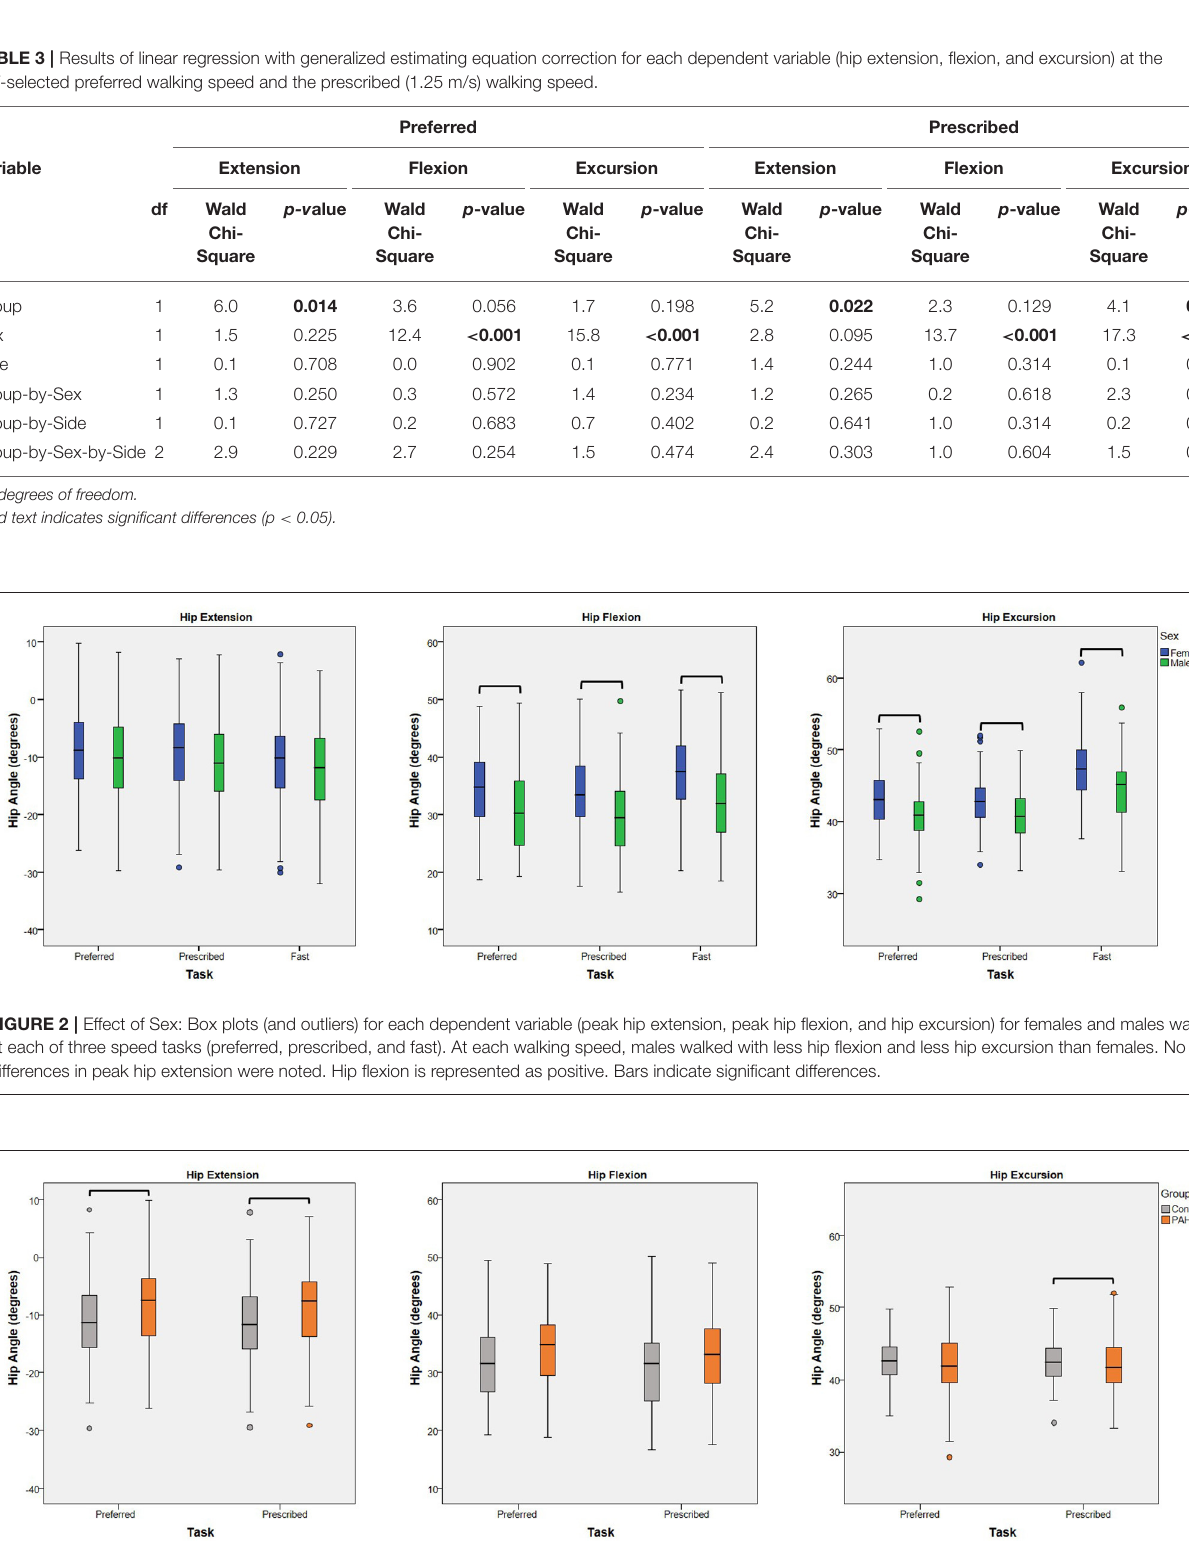
FIGURE 3 | Effect of Group: Box plots (and outliers) for each dependent variable (peak hip extension, peak hip flexion, and hip excursion) for individuals with pre-arthritic hip disease (PAHD) and healthy individuals without pain (Control). Peak hip extension was less for individuals with PAHD than controls at both speeds. At the prescribed speed, individuals with PAHD walked with less hip excursion than controls. Bars indicate significant differences.